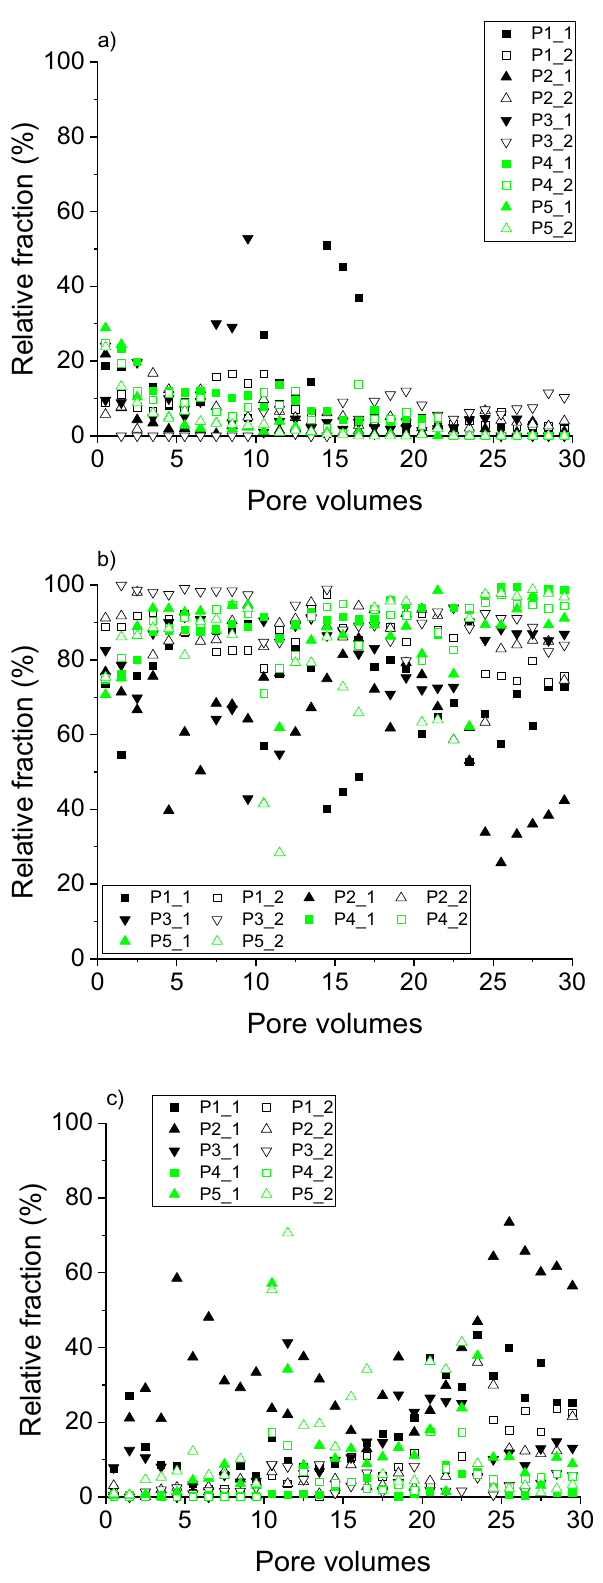
Figure 3. Relative distribution of aluminium eluted from soils with increasing degrees of podzolisation (P1 to P5) in irrigation experiments between fractions. ( a ) < 1 kDa, ( b ) 1 kDa–0.45 µm, ( c ) > 0.45 µm. ‘_1’ and ‘_2’ denote duplicate